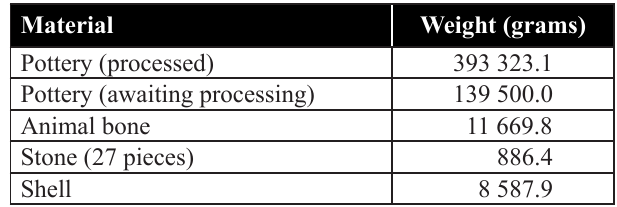
Table 1. Summary of material excavated at Grand Bay,